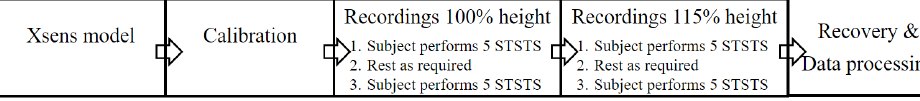
Figure 2. Flow chart depicting data capture procedure for each participant.